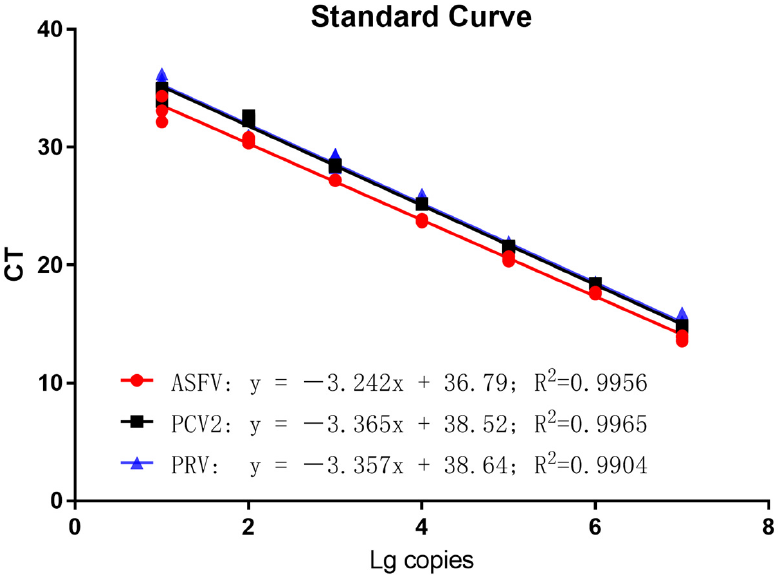
Figure 1. Standard curves of the multiplex real-time qPCR. Establishment of a standard curve for TaqMan probe-based multiplex real-time qPCR. The logarithm of the number of copies is the horizontal axis. The vertical axis represents Ct values. Each point represents the mean value of three duplicates of plasmid that have been diluted. The optimal standard formula for ASFV is y = 3.242x + 36.79, with a correlation coefficient of 0.9956; the optimal standard formula for PCV2 is y = 3.365x + 38.52, with a correlation coefficient of 0.9965; and the optimal standard formula for PRV is y = 3.357x + 38.64, with a correlation coefficient of 0.9904.